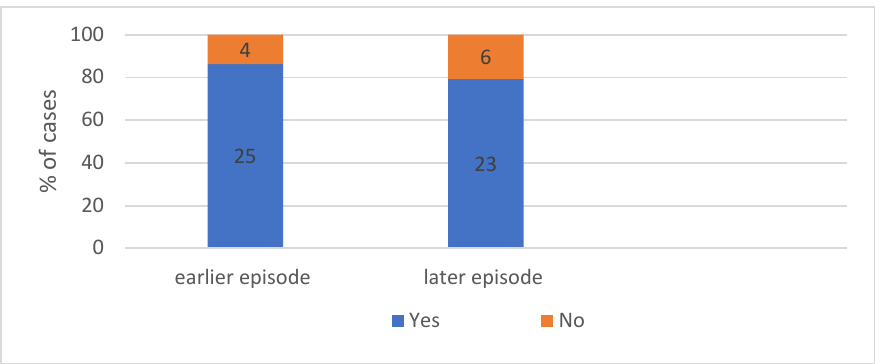
Figure 7. The percentage of earlier and later episodes in analysed group. Absolute values of numbers of patients are given in the diagram.